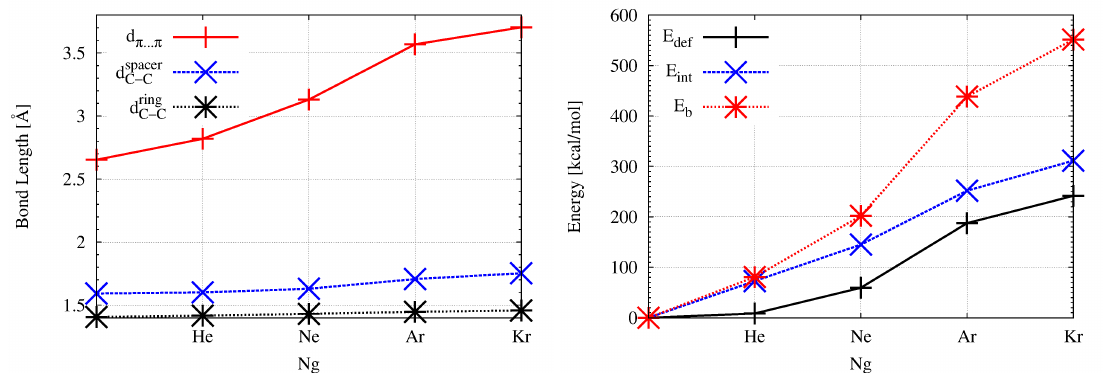
Figure 2. Dependence of the distance d π ··· π , the length of the bonds d s interaction, binding, and deformation energy ( right ) on the noble gas atom (Ng = He, Ne, Ar, Kr) in the endohedral Ng@superphane